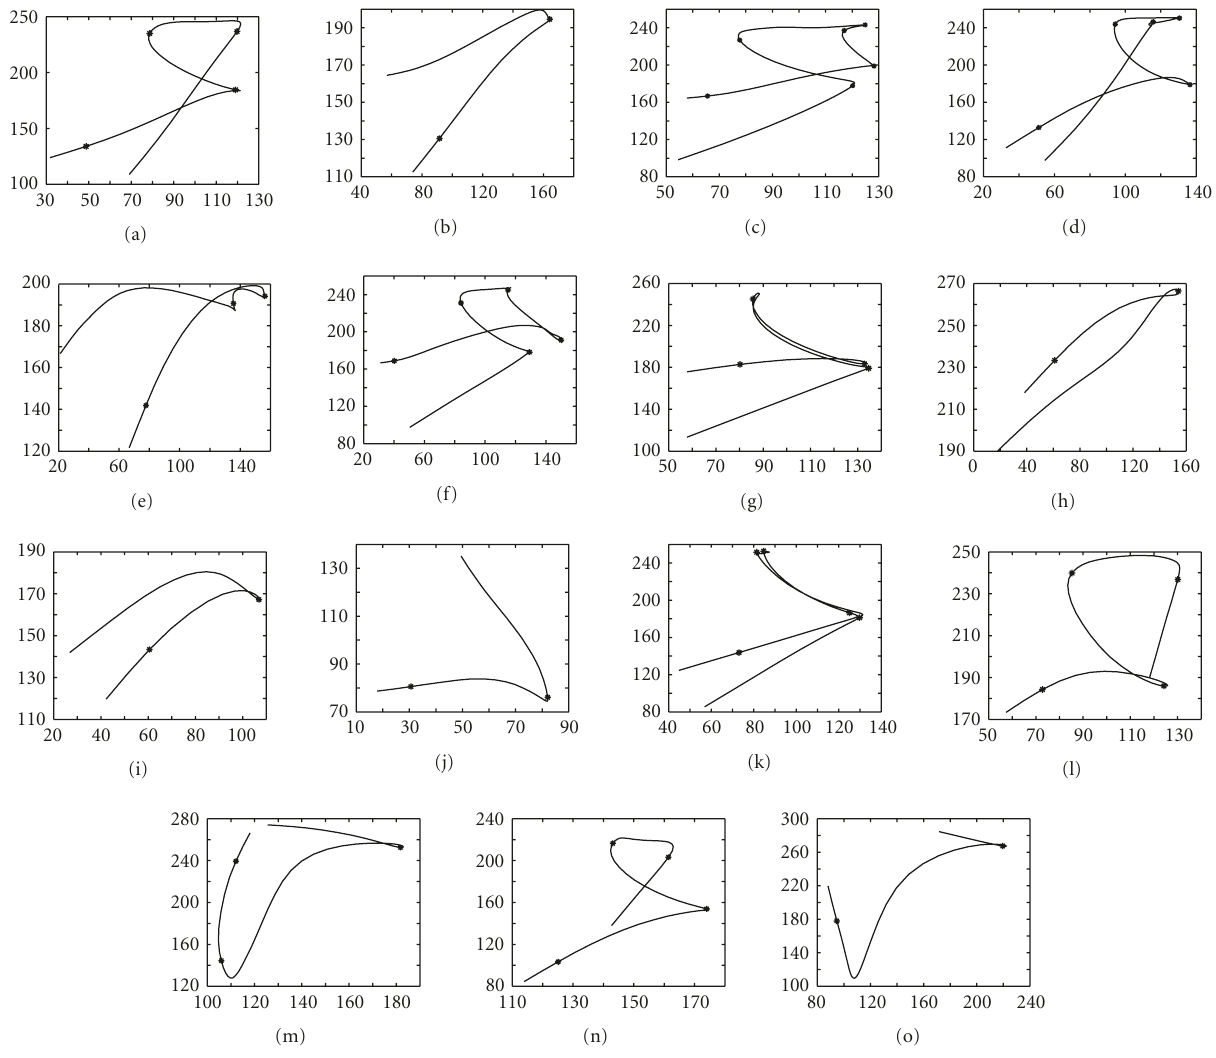
Figure 6: Motion trajectories of the hand in the UCF dataset for di ff erent actions. The dots along the trajectory denote segment boundaries